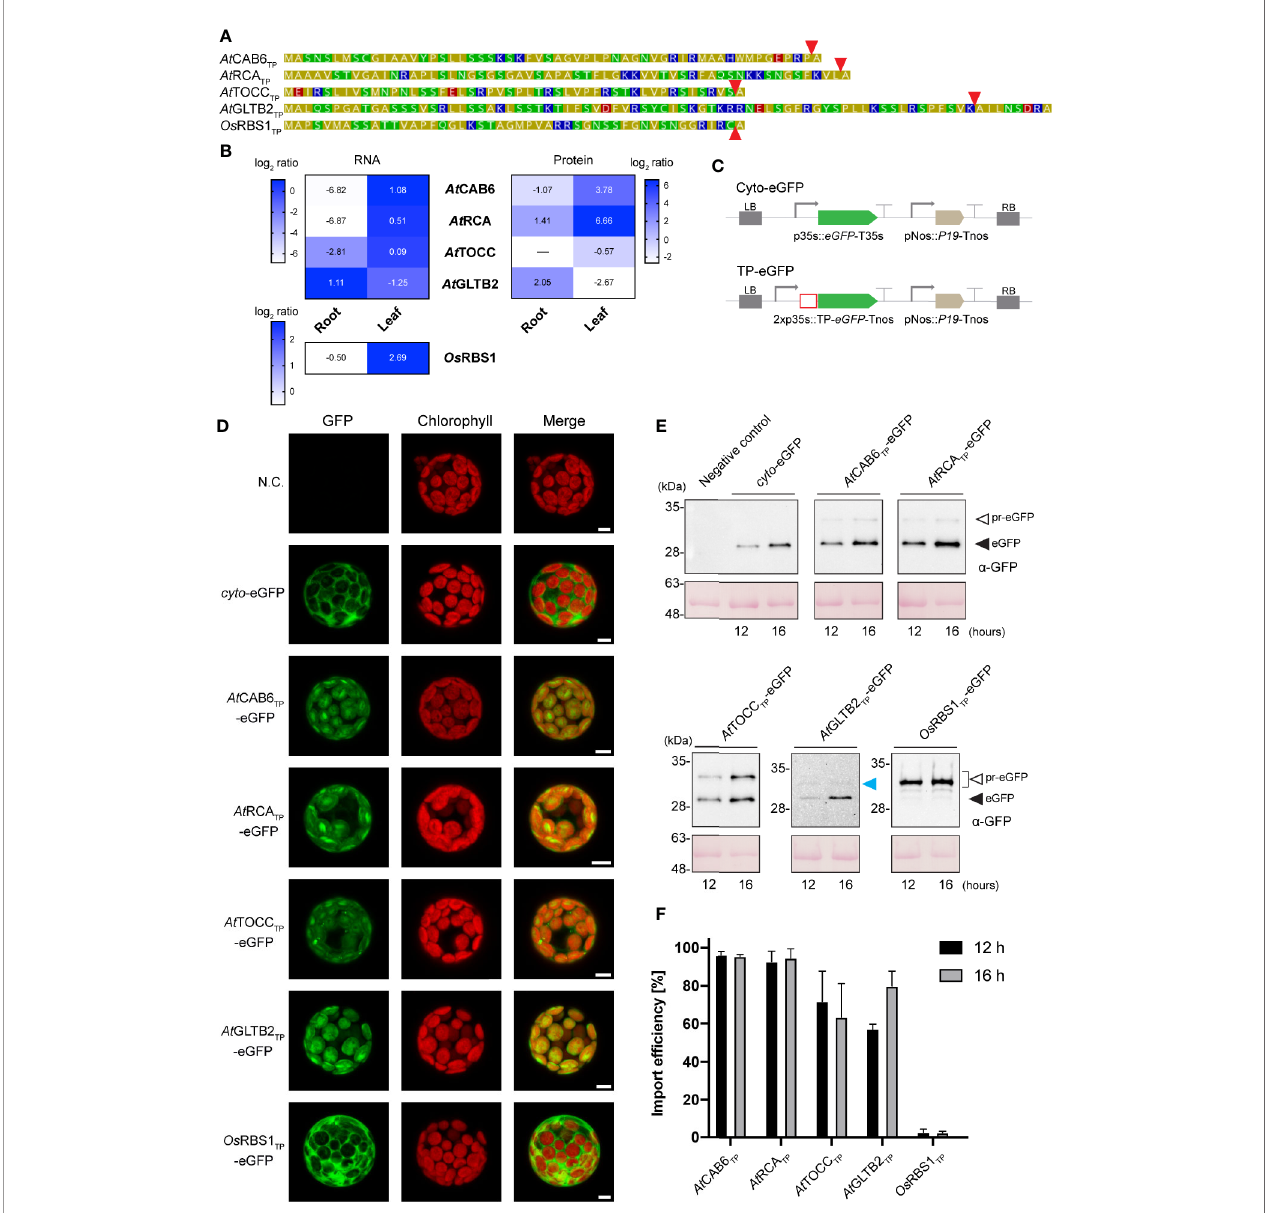
FIGURE 1 | In vivo chloroplast targeting of TP-eGFP fusion proteins in Arabidopsis leaf protoplasts. (A) Amino acid sequence of transit peptides (TPs) from A. thaliana and O. sativa . Coloring according to amino acid polarity as follows: Yellow: Non-polar; Green: Polar, uncharged; Red: Polar, acidic; Blue: Polar, basic. Red arrows indicate predicted Stromal Processing Peptidase (SPP) cleavage site. (B) Gene expression and protein levels of corresponding TP genes and mature proteins in A. thaliana and O. sativa . Gene expression data was retrieved from the Plant eFP browser, showing log 2 of fold change from microarray transcriptomics (Waese et al., 2017). Protein data was retrieved from AtProteome (Baerenfaller et al., 2008). Heatmap shows log 2 ratio from shotgun proteomics. (C) Schematic representation of the constructs used in A. thaliana transient expression assays leading to eGFP expression and localization. (D) Confocal laser scanning microscopy images of A. thaliana leaf protoplast expressing indicated TP-eGFP fusions. N.C. corresponds to “ Negative Control ” , nontransformed protoplasts. The columns show individual signals for eGFP (green, on the left) and chlorophyll auto fl uorescence (red, in the center). On the right, overlap of both signals (merge). Scale bars = 5 µm. (E) Western-blot analysis of import experiments. Protoplast isolated from A. thaliana leaves were transformed with indicated TP-eGFP fusions and total protein extracts were analyzed by Western blotting using anti-GFP antibody. The experiments were performed in three biological replicates and representative data is shown. White arrows (pr-eGFP) indicate precursor form; black arrows (eGFP) indicate, processed form; blue arrow indicates partially processed form. (F) Quanti fi cation of import ef fi ciency of TPs into Arabidopsis chloroplast. Import ef fi ciency was de fi ned as the percentage of the processed faster-migrating protein form relative to the total amount of expressed eGFP protein in each line. Data represent means (n = 3) with